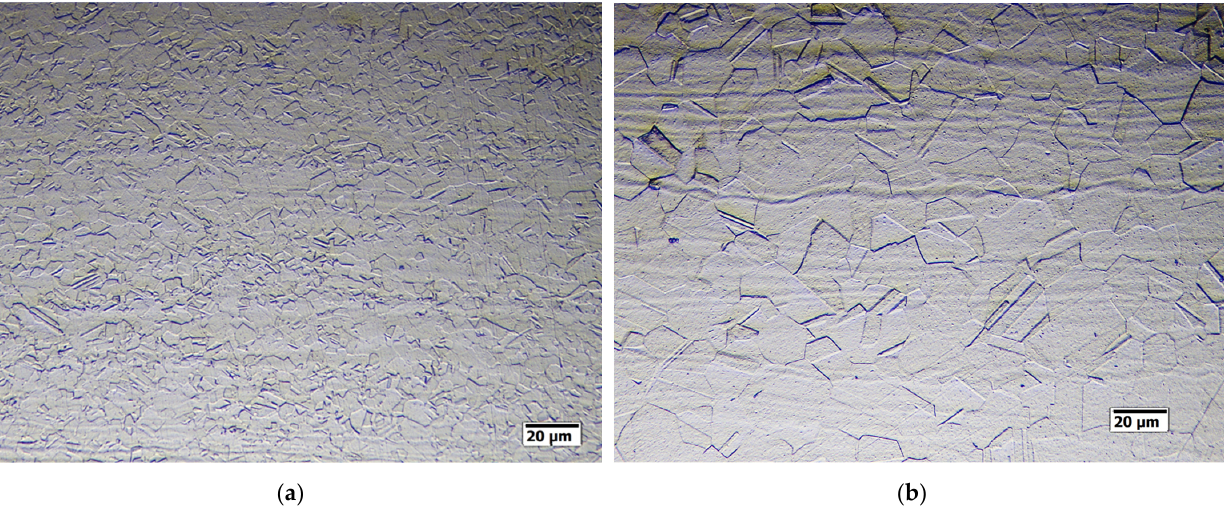
Figure 11. AISI 904 steel after cold rolling at 80% and annealing at ( a ) 1050 °C for 20 s and ( b ) 1150 °C for 20 s. Table 3. The average grain size for the recrystallized material for different process parameters.